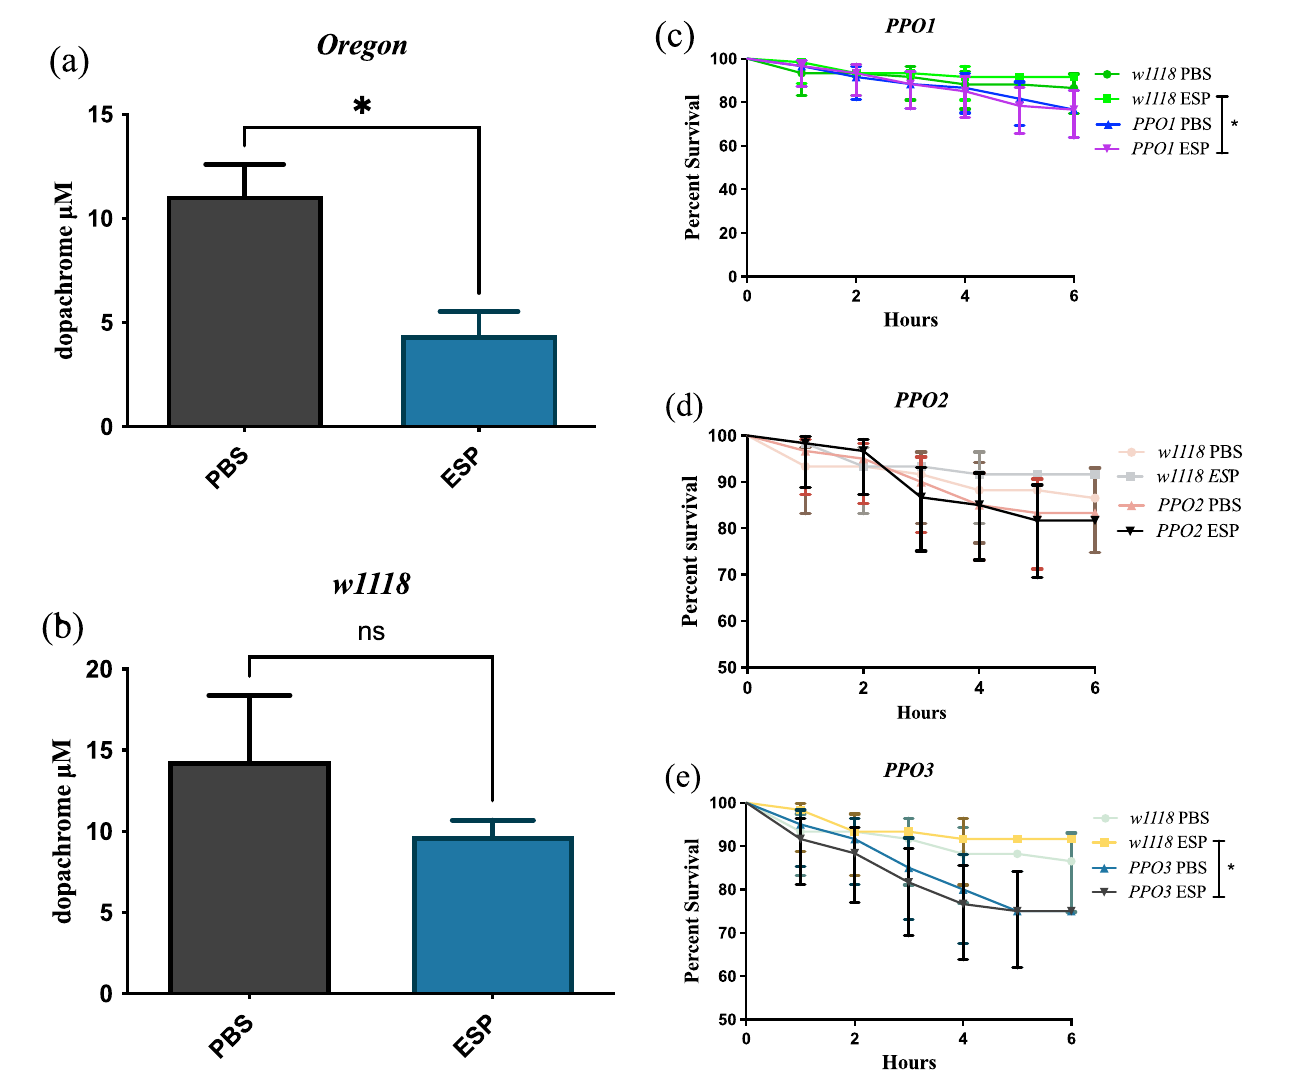
Figure 4. Effect of Steinernema carpocapsae excreted/secreted products (ESPs) on the Drosophila melanogaster phenoloxidase response. Adult flies of the ( a ) Oregon-R and ( b ) w1118 lines were injected during separate trials with 3 ng of ESPs from S. carpocapsae nematodes or PBS as a negative control. One hour post injection, phenoloxidase activity was assessed through the reduction of L-DOPA into dopachrome (* P < 0.01; One-way ANOVA). Mutant flies for ( c ) PPO1 , ( d ) PPO2 and ( e ) PPO3 genes were injected with nematode ESPs and individuals that received PBS served as a control group for each fly mutant line. The survival percentage of the PPO mutant lines was compared at 6 h after injection against the background line w1118 . Significant differences between survival curves were calculated using Log-rank (Mantel-Cox) Test (* P < 0.01; ns: non-significant